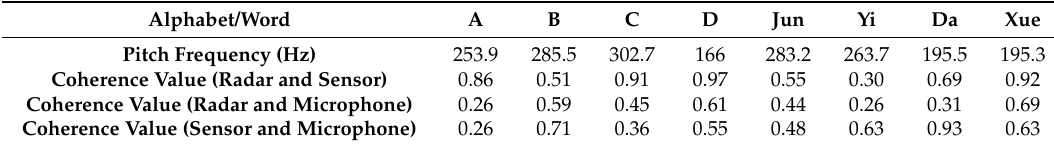
Table 2. Coherence results between the radar and microphone, radar system and vibration sensor, and between the microphone and vibration sensor for the spoken English letters “A”, “B”, “C”, and ”D” and a sentence of Mandarin Chinese,